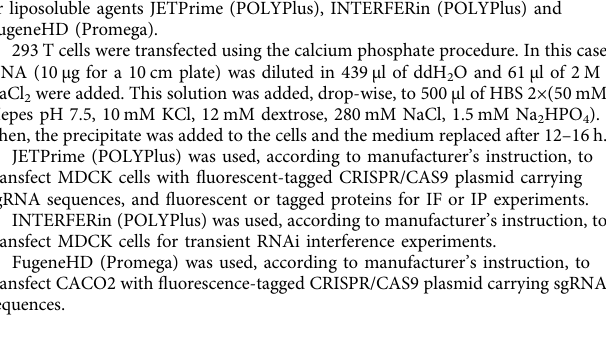
Fig. 6 Membrane- and SH3-mediated interactions guide IRSp53 localization. a Seven days-old 3D cysts from Caco-2 IRSp53 -KO #3 cells stably infected with murine GFP-IRSp53 WT, I-BAR*, CRIB*, SH3*, PDZ* were processed to visualize GFP-IRSp53 (green) and stained with an anti-ZO-1 antibody (magenta), rhodamine-phalloidin to detect F-actin (red), and DAPI (blue). Arrowheads indicate IRSp53 I-BAR* and SH3* at ZO-1-junctions. Scale bar, 10 µ m. b Top: 1 day-old 3D cysts from MDCK wild-type control (Ctr) or IRSp53-KO cells stably expressing RFP-RAB35 were processed to visualize RFP-RAB35 (red), stained with anti-PODXL (green) and anti- β -catenin (magenta) antibodies, and DAPI (blue). PODXL and RFP-RAB35 signals were analysed using masks (in yellow) to quantify RFP-RAB35 localization at the AMIS. Bottom: Quanti fi cation of RFP-RAB35 at the AMIS expressed as the ratio of RFP-RAB35 at the AMIS/ RFP-RAB35 out of the AMIS. Data are means ± SD. At least 15 cysts/ experiment were analyzed in n = 2 independent experiments. P